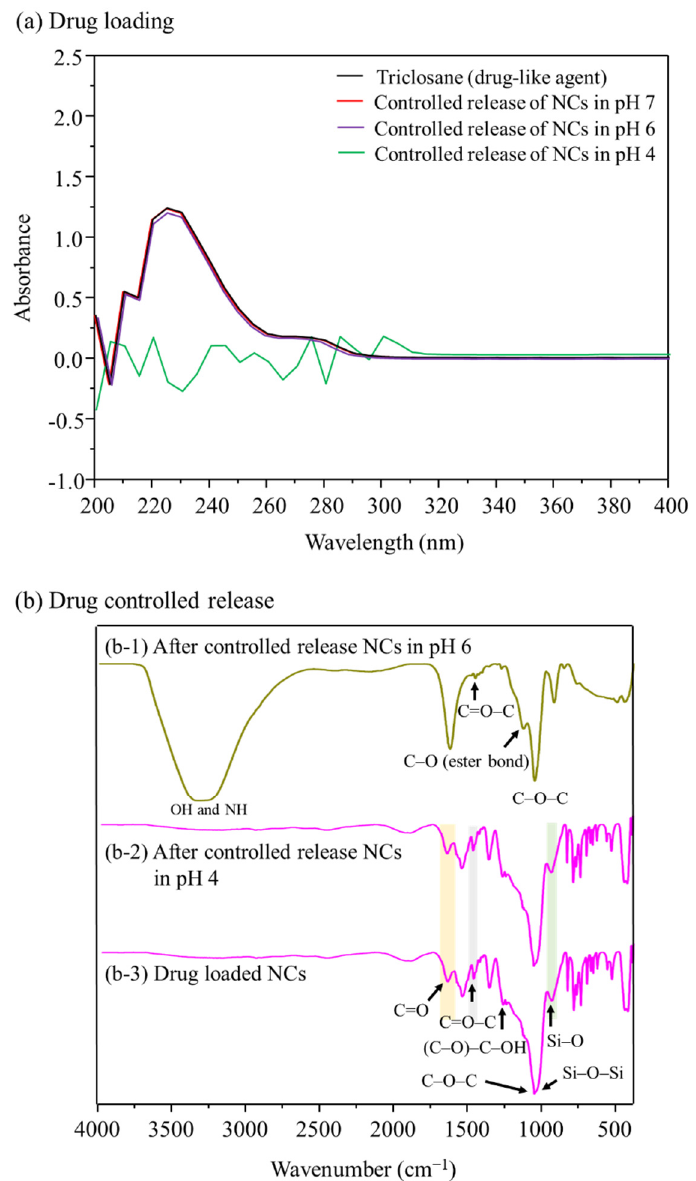
Figure 7. ( a ) Controlled release of triclosan from NCs at different pH values; ( b ) FT-IR spectra of the controlled-release NCs at different pH conditions: ( b-1 ) drug-loaded NCs, ( b-2 ) after controlled release at pH 4, and ( b-3 ) after controlled release at pH 6.